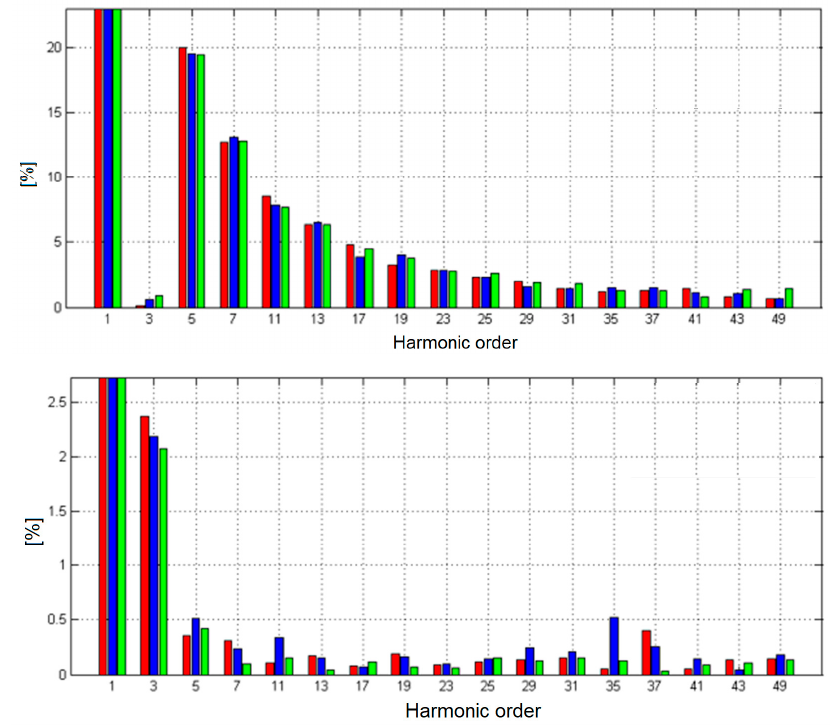
Figure 21. Harmonic spectra of three-phase currents ( top ) and voltages ( bottom )—acquired at the primary winding of the transformer used for supplying the excitation (harmonic weights > 1.2%).